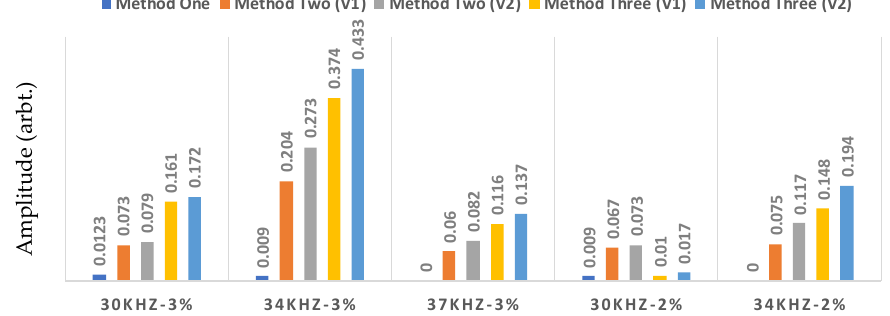
Figure 15. Bar graphs of the Safe zone margins of all methods in the first set of tests.